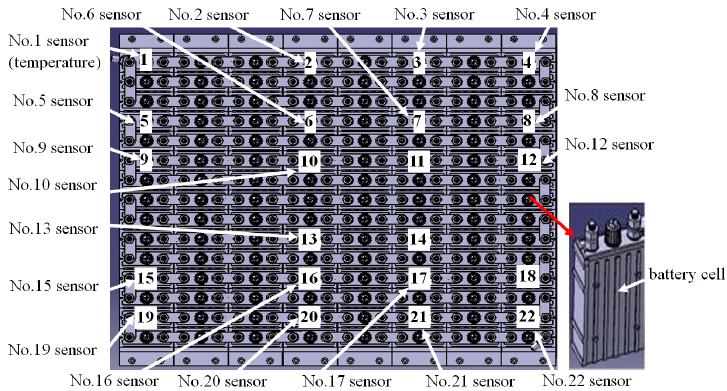
Figure 17. Sensor locations in the improved pack.